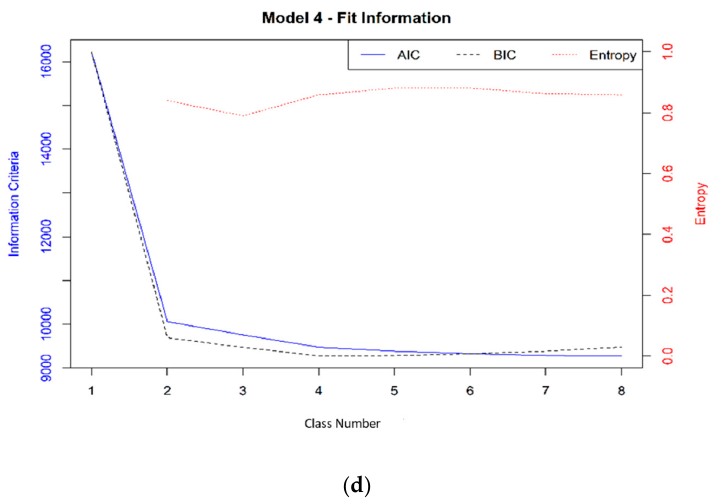
Figure 2. LCA Model’s AIC, BIC and Entropy. ( a ) Model 1, ( b ) Model 2, ( c ) Model 3, ( d ) Model 4.